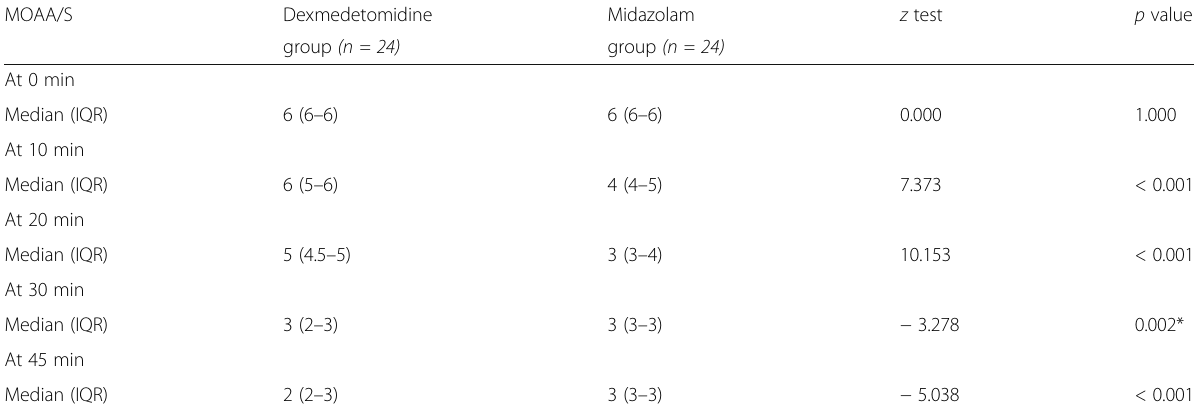
Table 7 Comparison between group D and group M as regards Modified Observer ’ s Assessment of Alertness/Sedation Scale